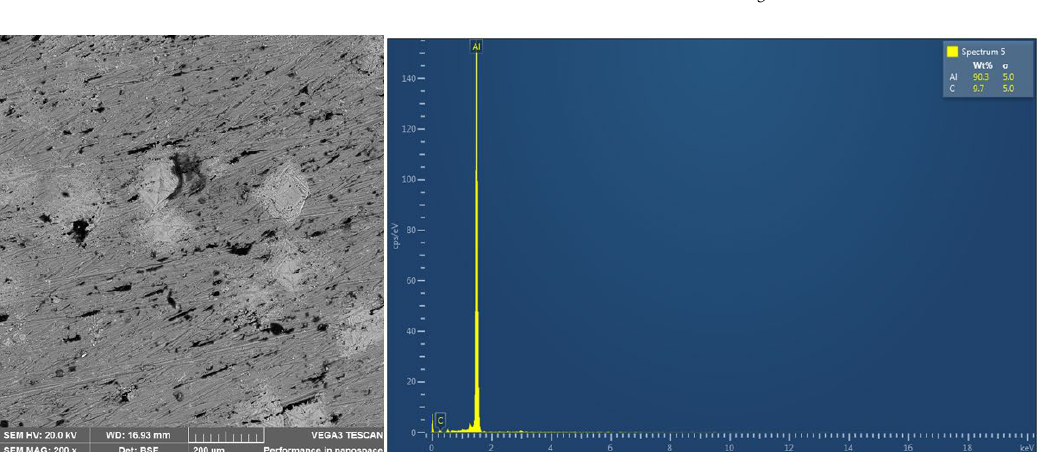
Figure 5. Scanning electron micrograph and EDS chart of 0% wood-particle-reinforced composite.